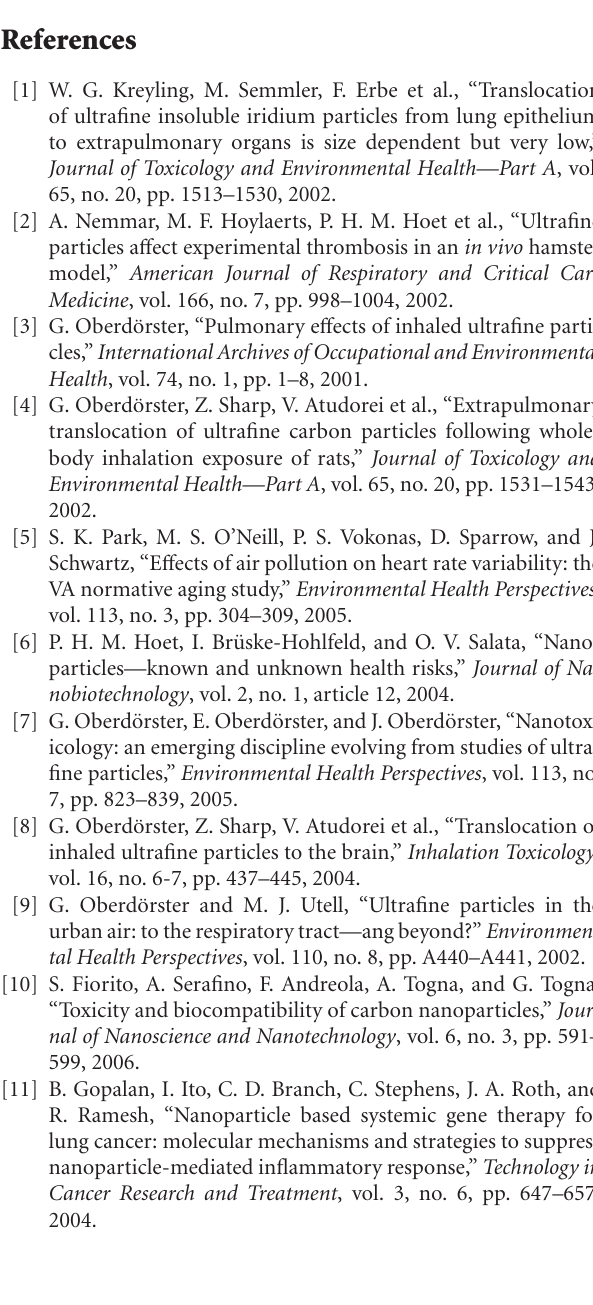
Correlation is significant at the 0.05 level (2-tailed).